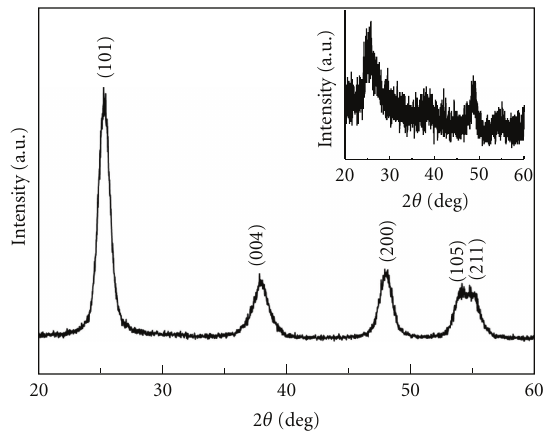
Figure 1: XRD patterns of the as-prepared TiO 2 after calcination at 400 ◦ C and before calcination (the